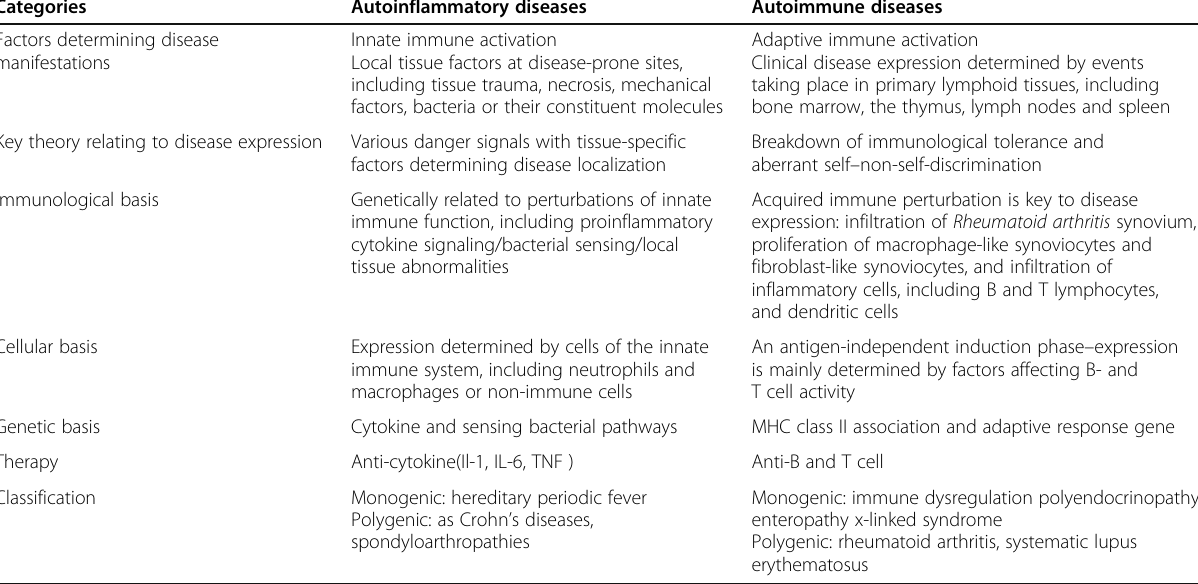
Table 3 The differences between autoinflammatory and autoimmune